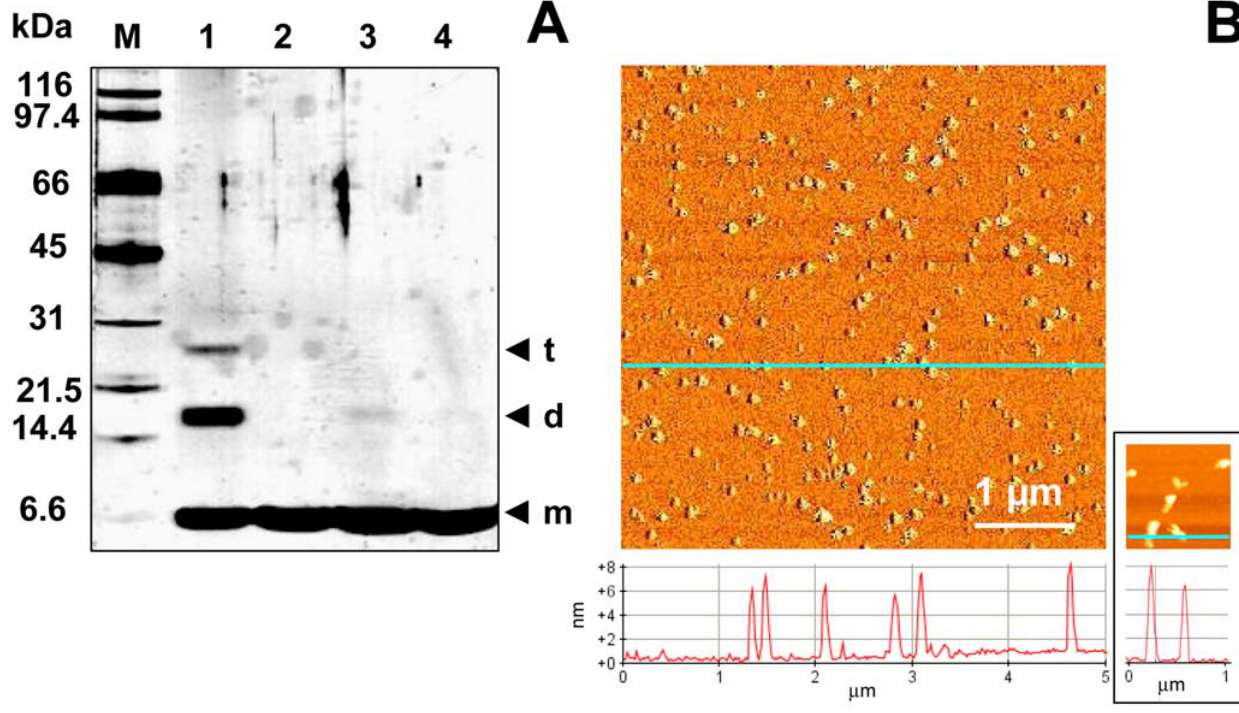
Figure 7. Redox-mediated aggregate disassembly. A) SDS-PAGE of Ub incubated for 2 weeks at 37 u C with 3 mol equiv of Cu II in 20% TFE before ( lane 1 ) and after ( lane 3 ) 2 h treatment with ascorbic acid. Control experiments performed on Ub incubated in water ( lane 2 ) or in 20% TFE ( lane 4 ) are also reported; B) Phase-mode AFM image and cross-sectional profile, taken along the cyan line, of Ub incubated for 2 months at 37 u C with 3 mol equiv of Cu II in 20% TFE after 2 h treatment with ascorbic acid. The inset at the bottom right shows an AFM image and a cross-sectional profile of Ub incubated for 2 weeks at 37 u C in 20% TFE.